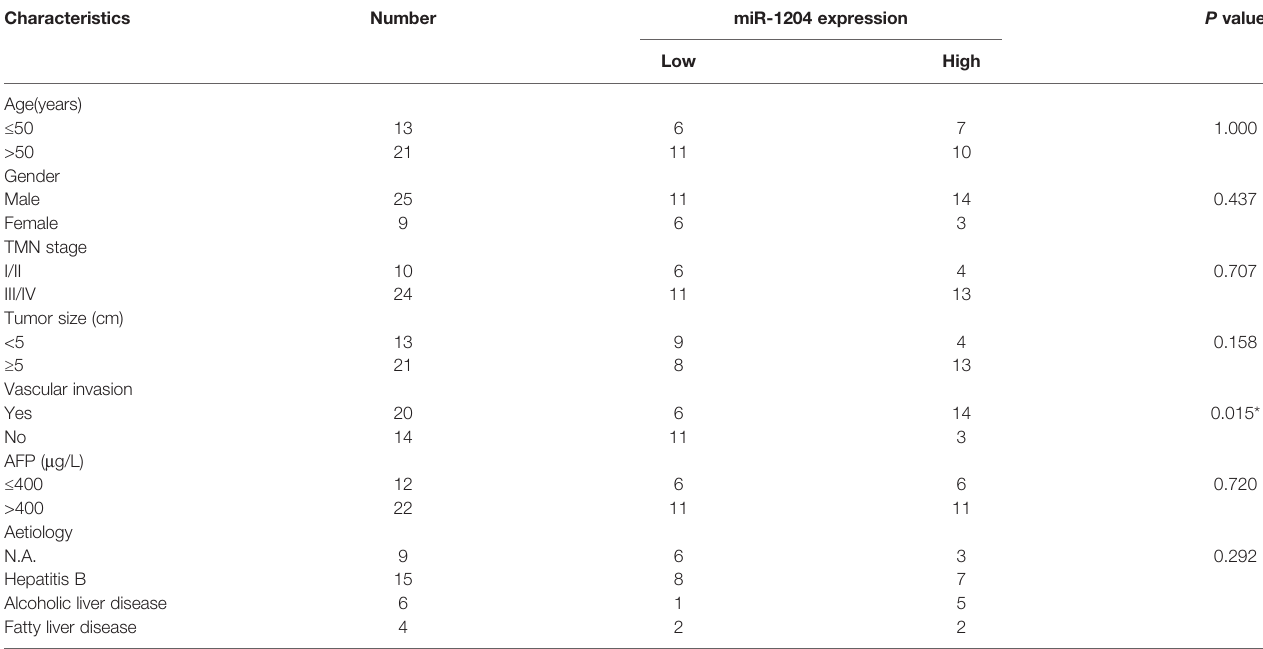
TABLE 3 | Correlation between miR-1204 expression and clinicopathological features in 34 HCC patients.